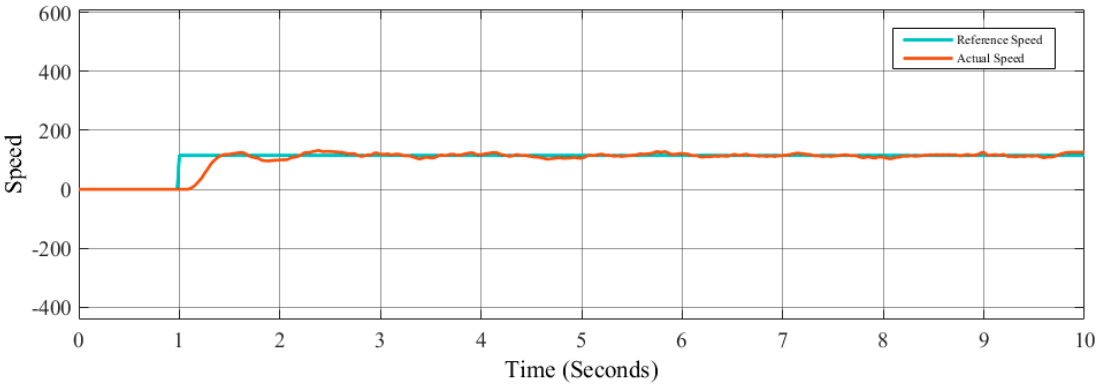
Figure 16. Simulation for PI controller.